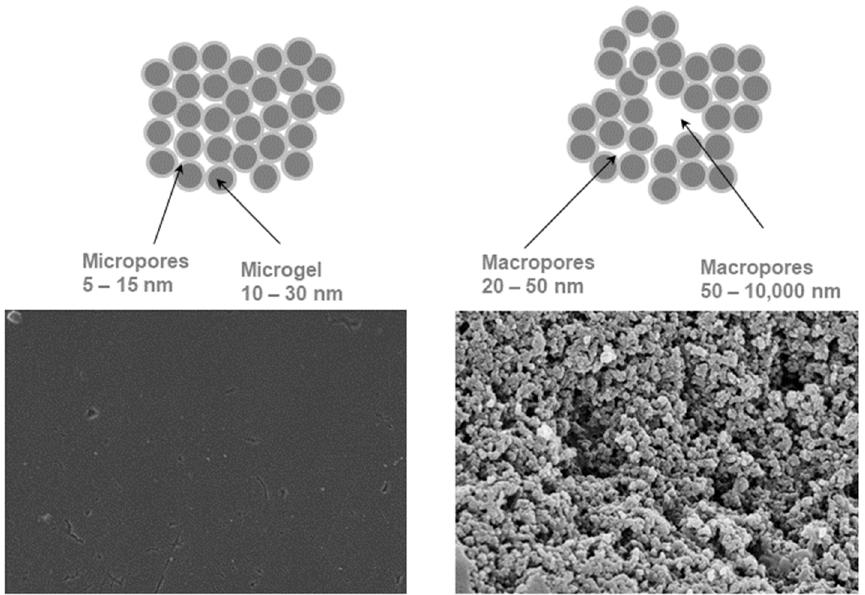
Figure 2. Gel (microporous) and macroporous ion exchangers.